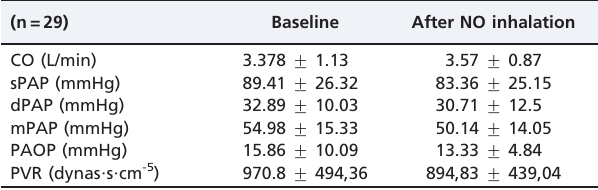
Table 1 - Baseline patient characteristics. Table 2 - Hemodynamic variables at baseline and after vasoreactivity